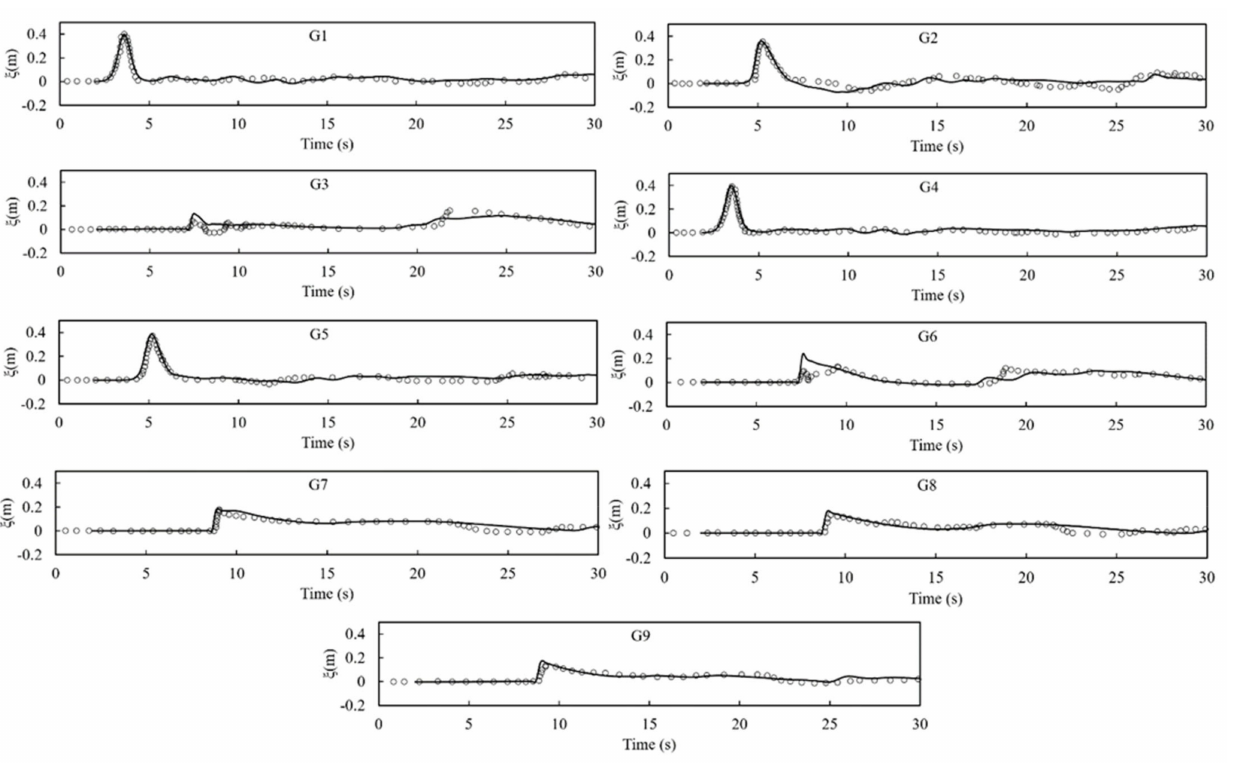
Figure 16. Comparison of simulated and measured free surface elevations at gauge locations. Measured data (circles), numerical results (solid lines).